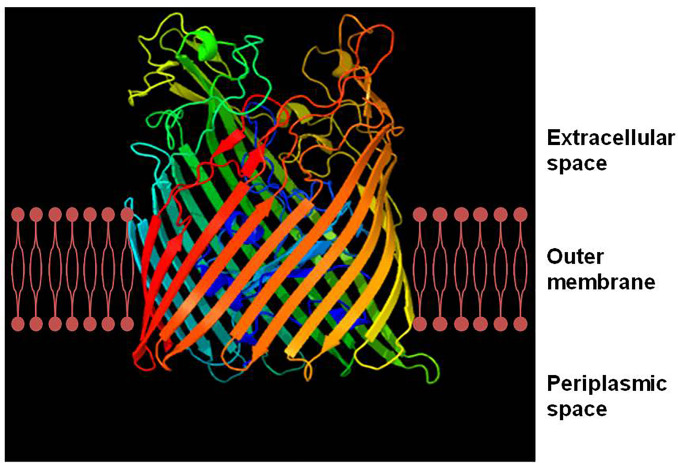
Ribbon diagram of FepA, a TonB-dependent transporter (TBDT) from Escherichia coli. TonB-dependent transporters possess two domains, a 22-stranded anti-parallel β–barrel spanning the outer membrane and an N-terminal globular plug domain that resides within the barrel. The β–strands of the barrel are connected on the extracellular side by long flexible loops and on the periplasmic side by short turns. The ribbon diagram of FepA was generated with the Phyre2 software (Kelley et al., 2015).